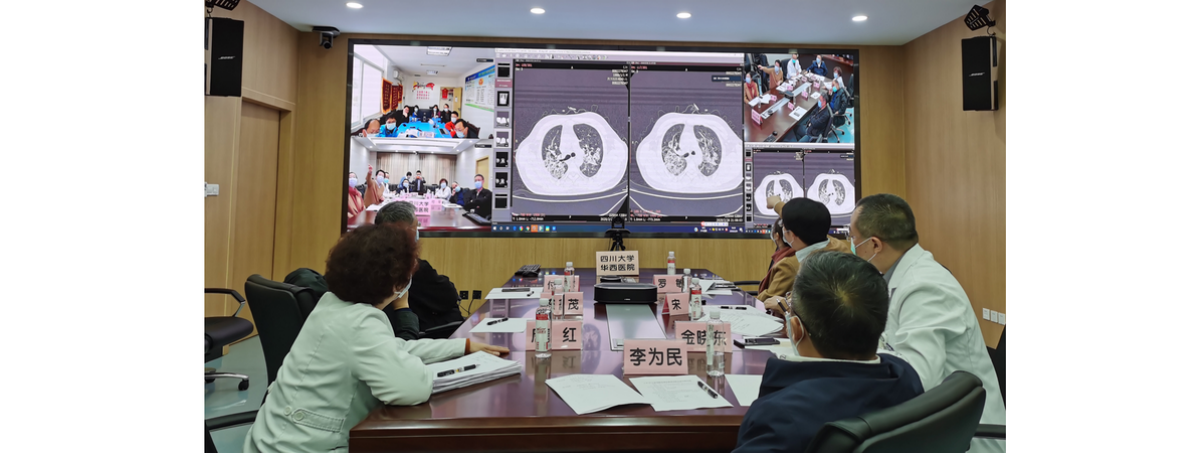
Figure 3. Web-based, real-time video telemedicine for consultations provided by a multidisciplinary team to deal with cases of coronavirus disease (COVID-19) in Western